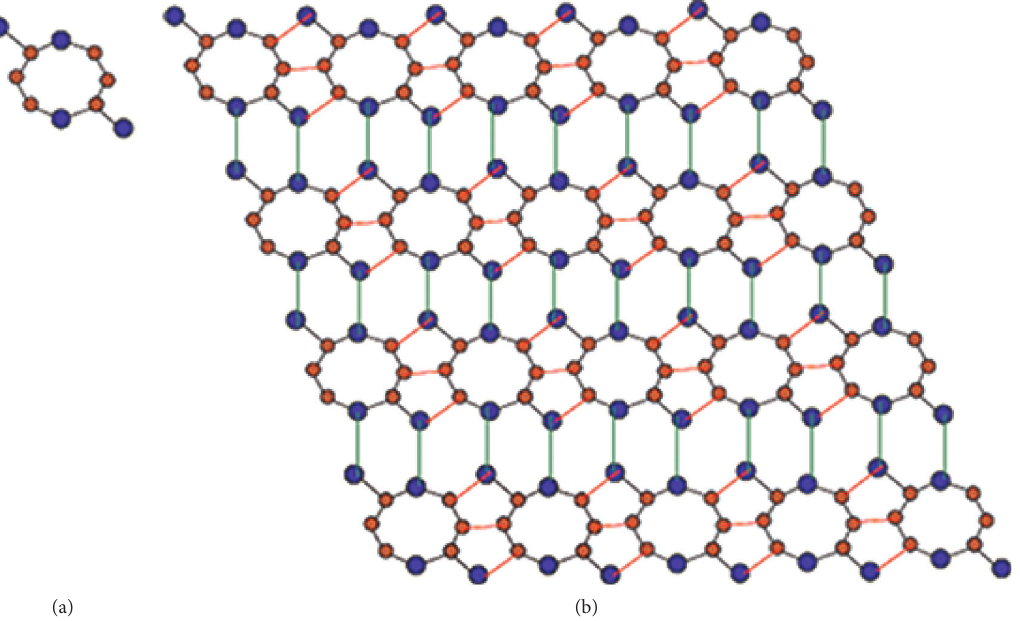
Figure 9: 2D structure of Si